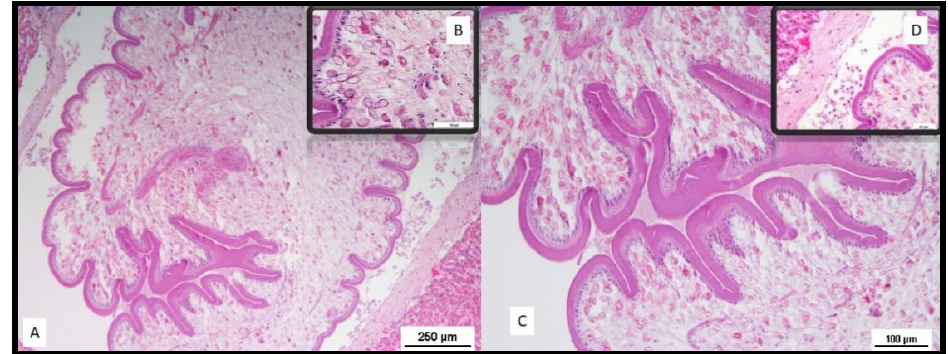
Figure 6. Histological lesions; (A) microscopic picture of Mesocestoides lineatus cysts on liver, hematoxylin and eosin (HE) stain. Bar = 250 µm; (B) inset: microtriches, which are fine hair-like projections of the cuticle, features typical of cestodes; (C) tetrathyridium with scolex withdrawn into a deep invagination canal. Bar = 100 µm; (D) inset: tegument surrounded by a loose connective tissue stroma and some inflammatory cells.